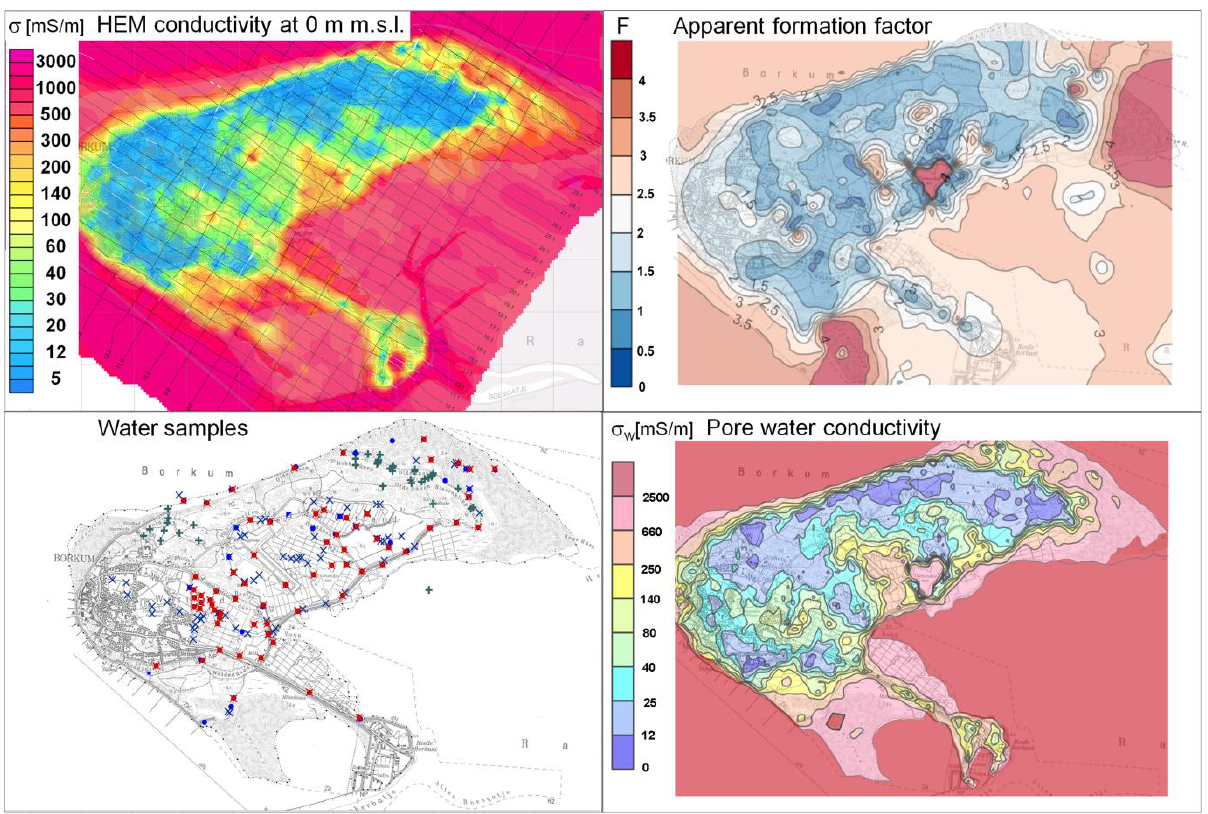
Fig. 6. Regionalisation of electrical conductivity data at the water table by means of data from helicopter-borne electromagnetics (HEM) and apparent formation factors. Top left panel: electrical conductivities at 0mm.s.l. from HEM, (bottom left panel) locations of electrical conductivity from manual readings at the water table (see Fig. 4), top right panel: apparent formation factors at the water table, bottom right panel: regionalised conductivity map at the surface of the groundwater table.